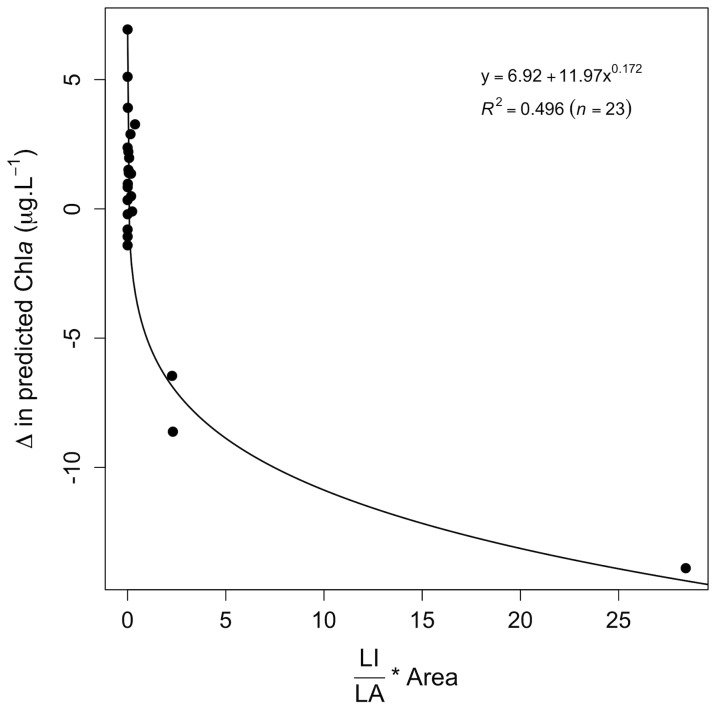
Relationship between the differences in predicted Chla between two contrasting scenarios (“reduced LI” and “increase LI”; see text for details) and the ratio between urban (LI) to agricultural (LA) covers weighted by the catchment size (Area).